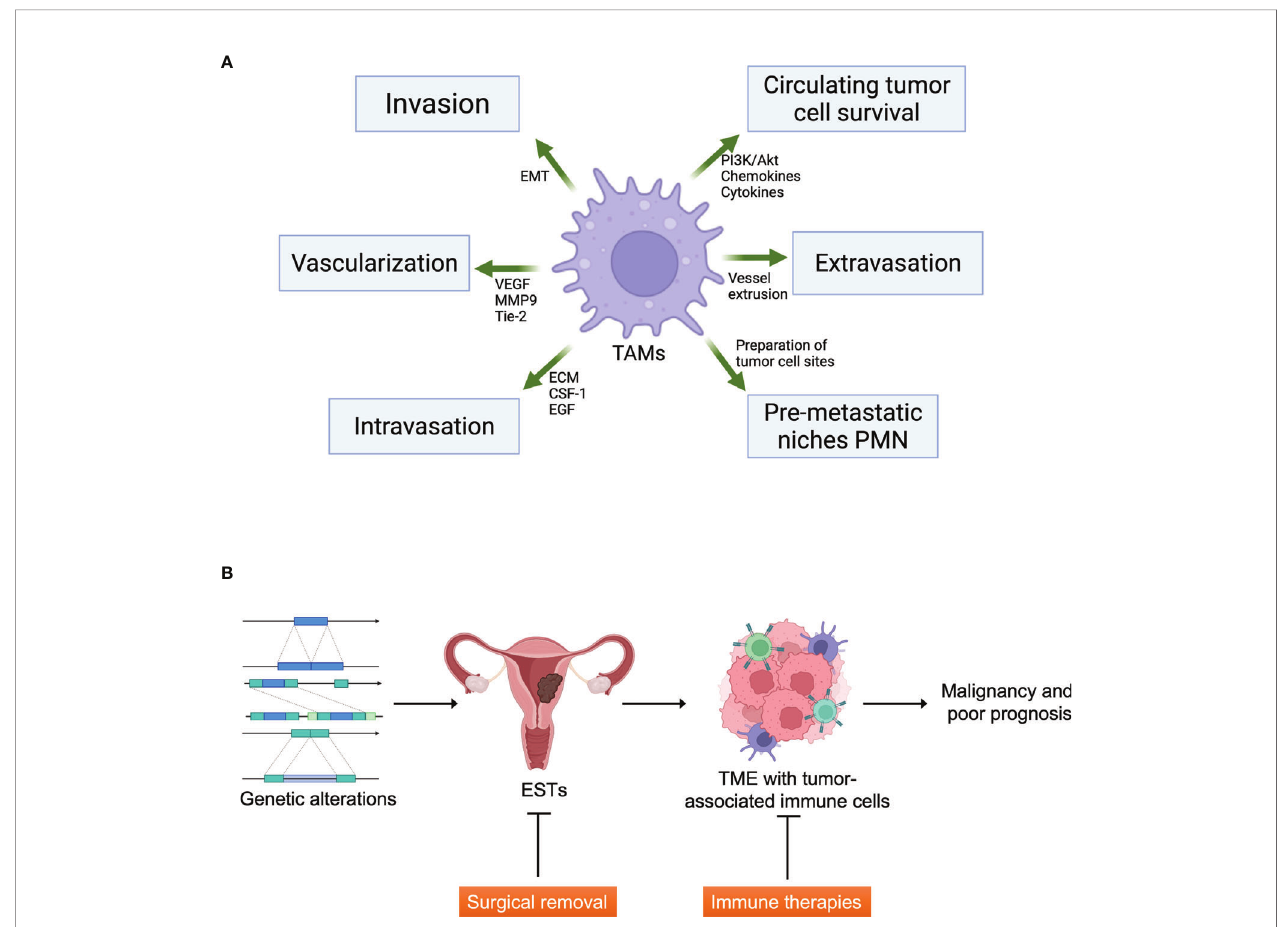
FIGURE 1 | Tumor microenvironment and ESTs. (A) The functions of tumor-associated macrophages (TAMs) in tumor microenvironment formation. TAMs affect tumor cell metastasis including invasion, vascularization, intravasation, formation of pre-metastatic niches and protection of circulating tumor cells. EMT, epithelial- mesenchymal transition; VEGF, vascular endothelial growth factor; MMP9, matrix metallopeptidase-9; ECM, extracellular matrix; CSF-1, colony-stimulating factor-1; EGF, epithelial growth factor. Created with Biorender.com. (B) The graphical abstract of ESTs and therapeutic strategies. Immune therapies can be an additive strategy to cure malignant ESTs targeting TME. Created with